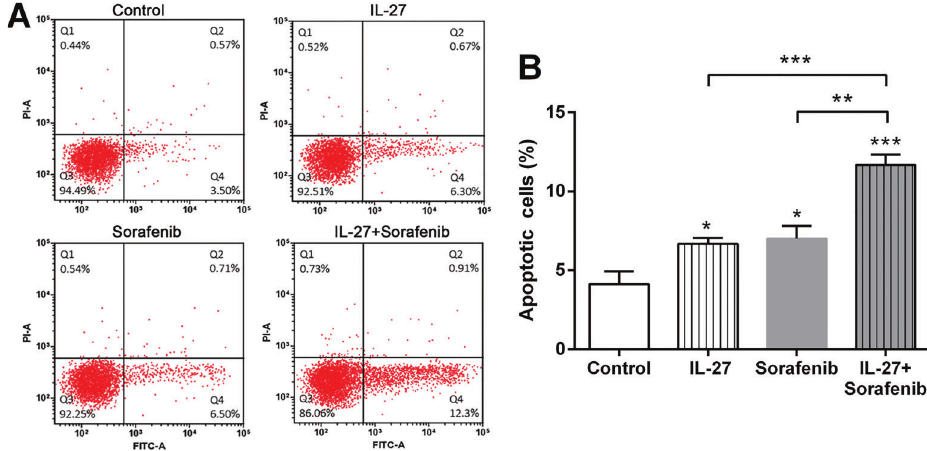
Figure 2. Effect of IL-27 (50 ng/mL) and sorafenib (2 m M) alone or their combination on HTB-9 cell apoptosis assessed by fl ow cytometry ( A , B ). Cells cultured with blank medium acted as control. Data are reported as the mean ± SE of 4 independent experiments. *P o 0.05; **P o 0.01; ***P o 0.001 compared to control unless indicated otherwise ( t -test). IL-27: interleukin 27.